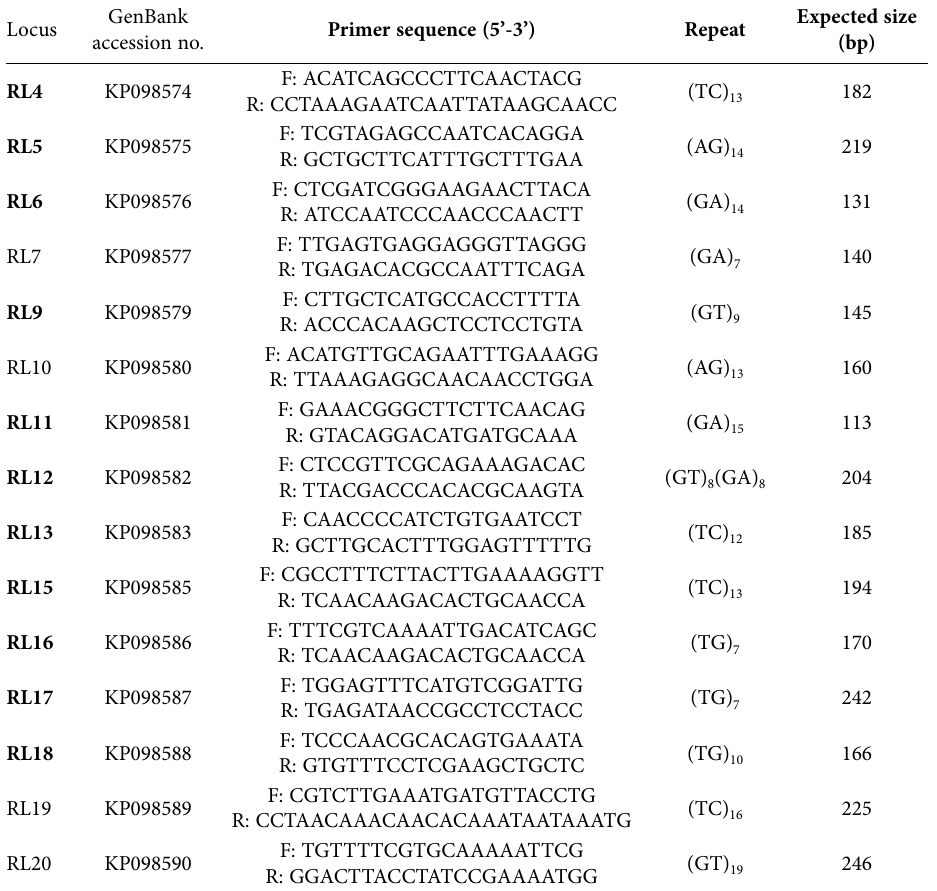
Table 2. Characteristics of 15 microsatellite markers developed in Ruta lamarmorae . Shown for each marker are the GenBank accession number, forward and reverse sequences of the primer pair, repeat motif, and size of the expected PCR product (bp). Primers in bold were used for genotyping; locus RL9 was excluded from statistical analyses as all genotyped individuals of R. corsica and R. lamarmorae were het- erozygotes for the same two alleles.